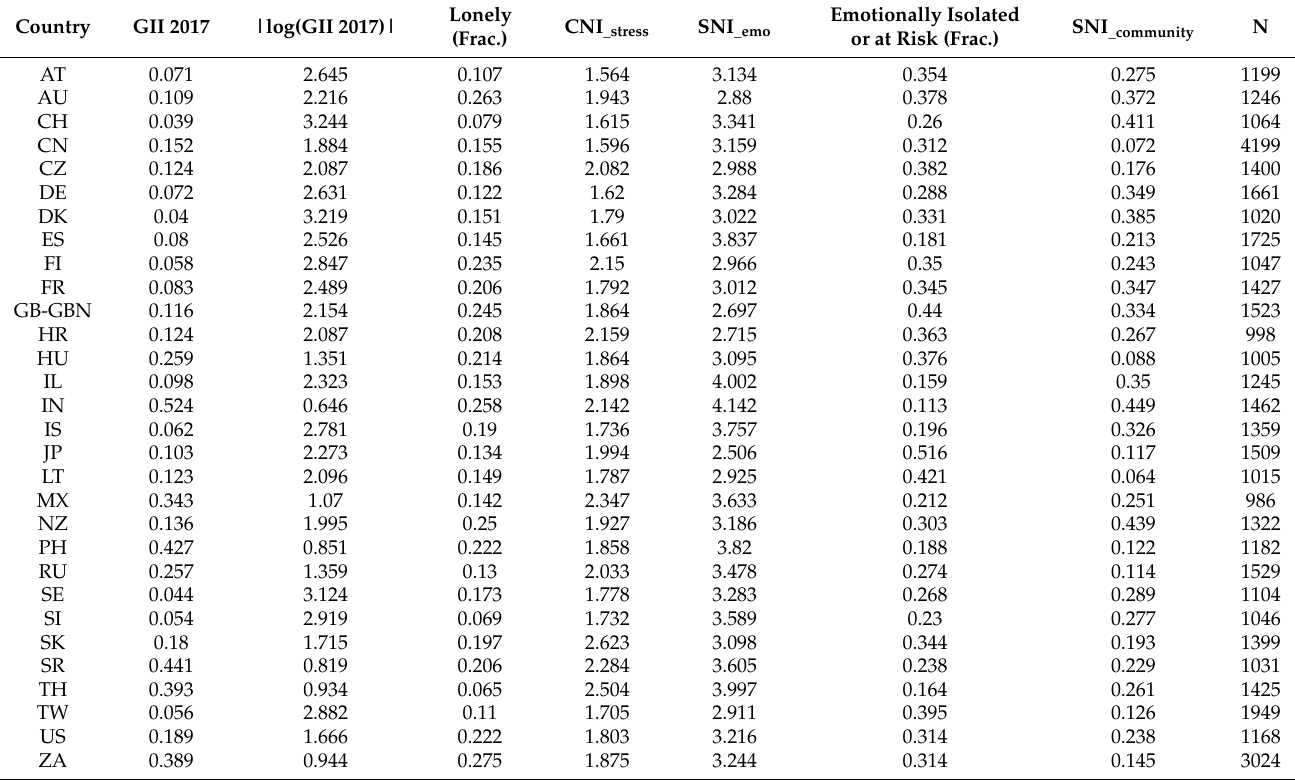
(SNI community ). In terms of gender equality, Table 1 shows that the values on the GII ranged from very low gender inequality (0.040) in Denmark (DK) to very high levels of gender inequality (0.524) in India (IN). The average country displayed a medium level of gender inequality (M = 0.172). The prevalence of loneliness varied from 0.065 points (or 6.5%) in Thailand (TH) to 0.275 (or 27.5%) in South Africa (ZA). The country-level average was 0.175 (or 17.5%). The level of close-network stress, as measured by CNI stress , ranged from 1.564 points in Austria (AT) to 2.623 points in Slovakia (SK). The average level of 1.920 on the country level pointed to medium-to-low average levels of close-network stress. The average of the country averages on the SNI emo was 3.280. The average fraction of individuals who were emotionally isolated or at risk was 30.0%, pointing towards a normality of stable emotional network inclusion for a large majority of the individuals in most of the countries in the sample. In contrast, SNI community only ranged between 0.064 points in Lithuania (LT) and 0.449 points in India, averaging 0.251 across all countries. Community integration, as measured here, appears to have been rather weak across the countries in the sample. For further information on the sample, an in-depth country-level description of data is given by Hadler et al. 2020 [78], and a table describing the socio-demographic composition of the sample is included in Appendix A (Table A6). Table 1. Country-level descriptive